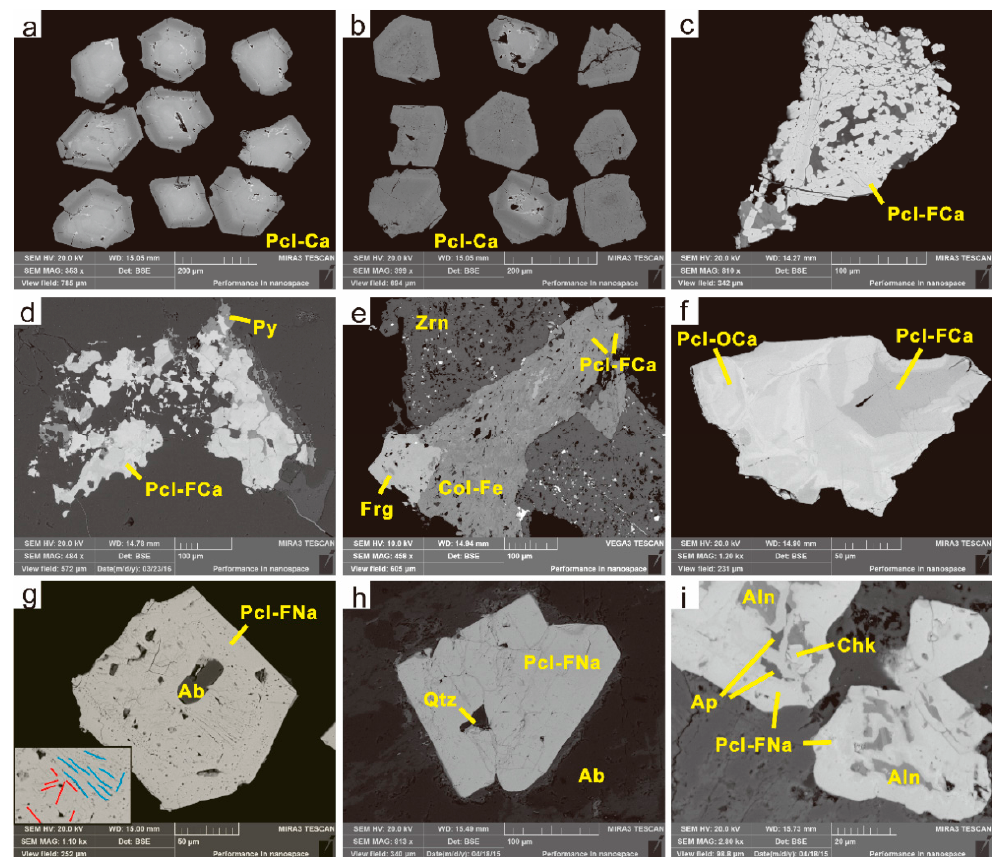
Figure 12. BSE images of the pyrochlore group minerals and associated minerals. ( a ) Calciopyrochlore with fine oscillatory zoning (pyrochlore I); ( b ) calciopyrochlore with oscillatory zoning (pyrochlore II); ( c ) fluorcalciopyrochlore aggregates (pyrochlore II); ( d ) fluorcalciopyrochlore with replacement texture (pyrochlore III); ( e ) an altered columbite-(Fe) crystal replaced by fluorcalciopyrochlore (pyrochlore III); ( f ) fluorcalciopyrochlore with replacement texture (pyrochlore III); ( g ) fluornatropyrochlore with albite and tiny (<1 µ m) linear inclusions (pyrochlore IV), the red line represents the straight